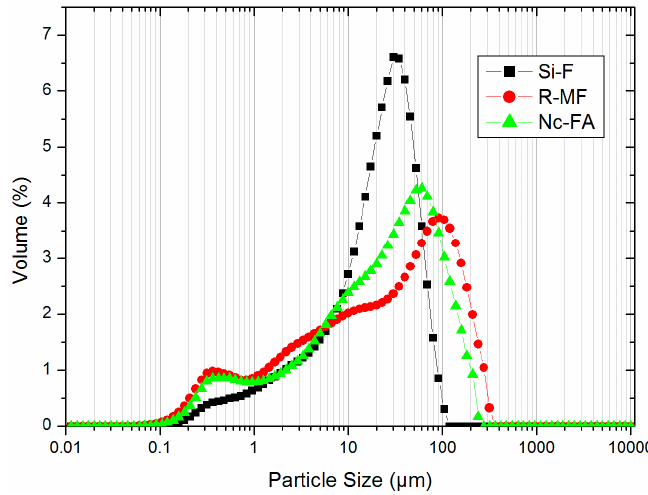
Figure 3. Particle size distribution of Si-F, R-MF and Nc-FA.